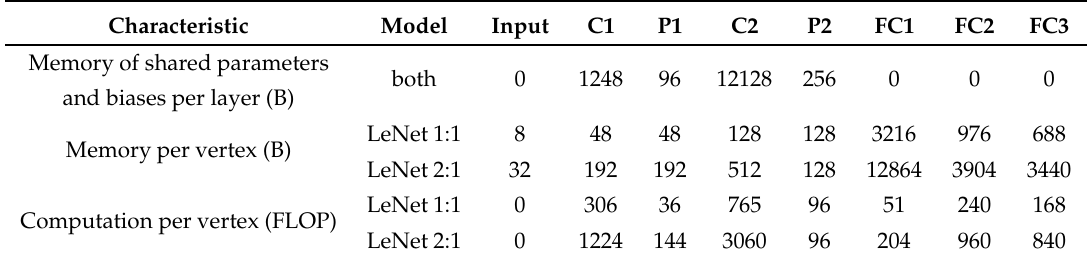
Table 3. Per-layer and per-vertex characteristics of each LeNet model used in this